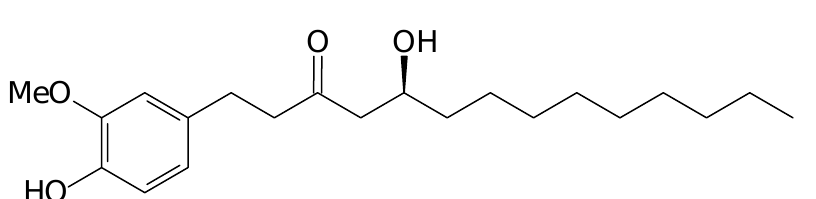
Figure 1. Structure of